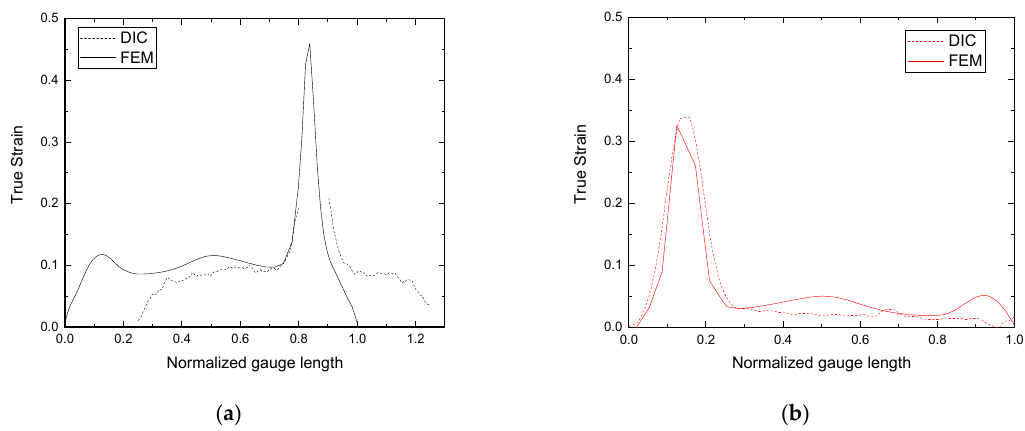
Figure 20. Visual comparison between DIC analysis and FE simulation strain map results for smooth specimens at the last captured frame before rupture for ( a ) 0.001 s − 1 and ( b ) 0.5 s − 1 strain rates.